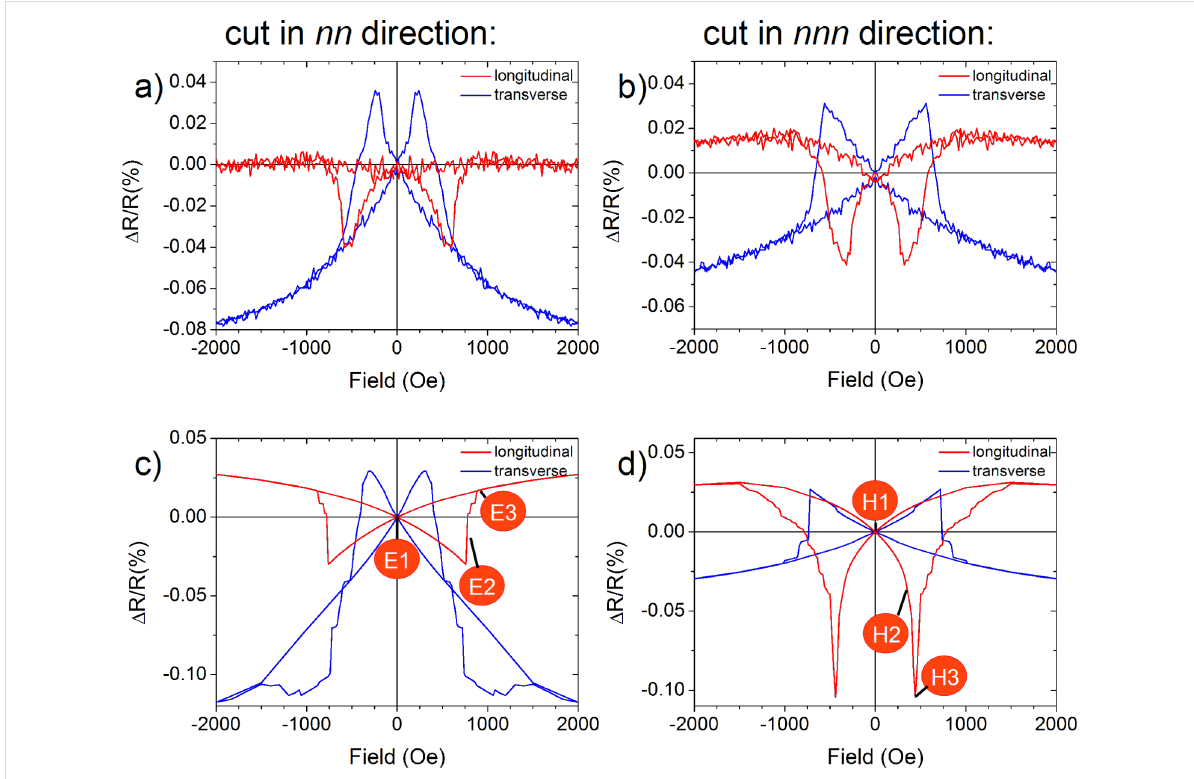
Figure 8: Measured AMR curves (a) for the current direction along nearest neighbours (nn) and (b) next nearest neighbour directions (nnn) in longitu- dinal (red) and transverse (blue) geometry of the external field at T = 77 K. Panels (c) and (d) present micromagnetic simulations of the correspond- ing geometries in identical colour code. The red indicators in panels (c) and (d) mark significant points of AMR curves for easy (E) and hard axis (H) magnetic switching. Reproduced with permission from [29], copyright 2013 IOP Publishing